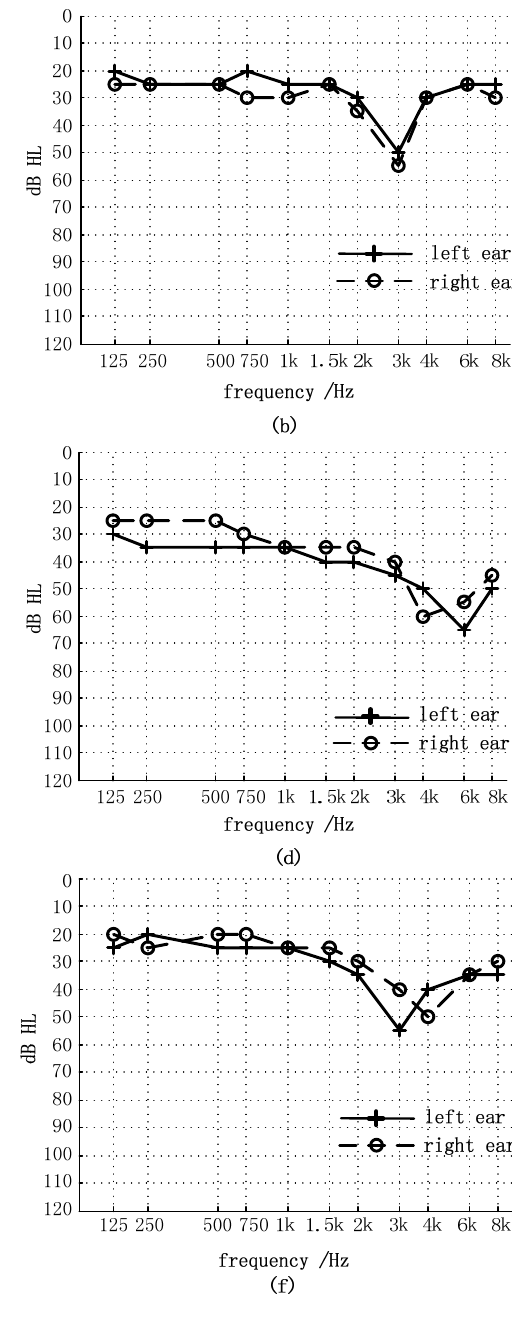
Figure 4. Pure tone audiograms for the subjects: ( a ) S1; ( b ) S2; ( c ) S3; ( d ) S4; ( e ) S5; ( f ) S6.